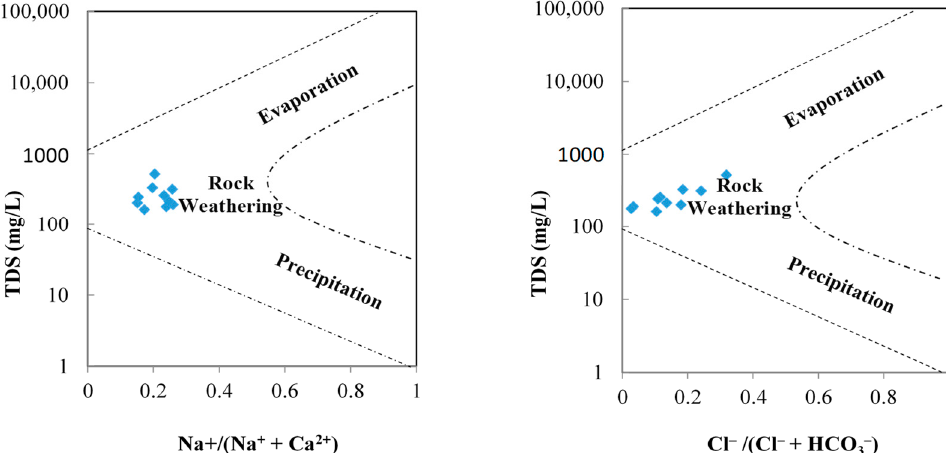
Figure 4. Gibbs diagrams showing the natural processes controlling the groundwater chemistry in the study area. The dotted lines indicate the boundaries of the natural processes.